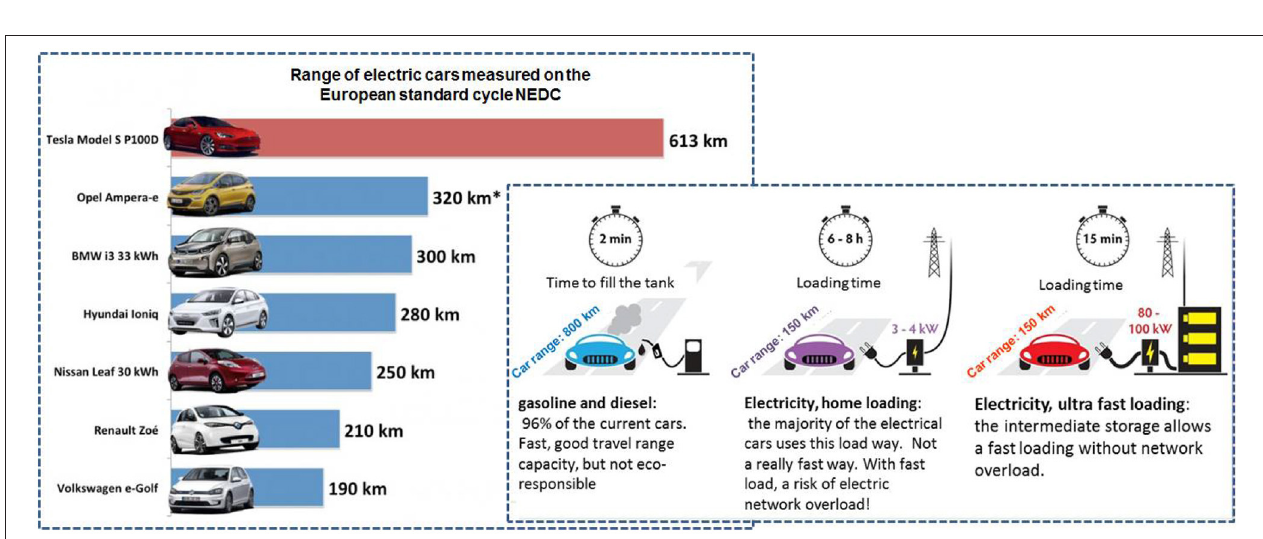
FIGURE 11 | CO 2 emission in the different mean of transport https://www.europarl.europa.eu/news/en/headlines/society/20190313STO31218/co2-emissions-from- cars-facts-and-figures-infographics. (Left) Emissions breakdown by transport mode (2016); (Right) Range of life-cycle CO 2 emissions for different vehicle and fuel